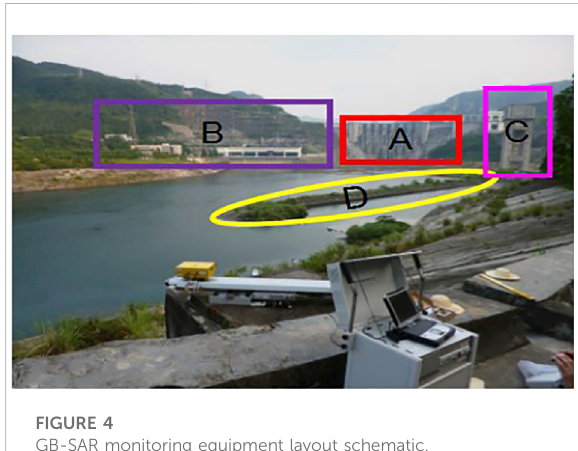
FIGURE 3 GB-SAR image corresponds to the physical relationship.